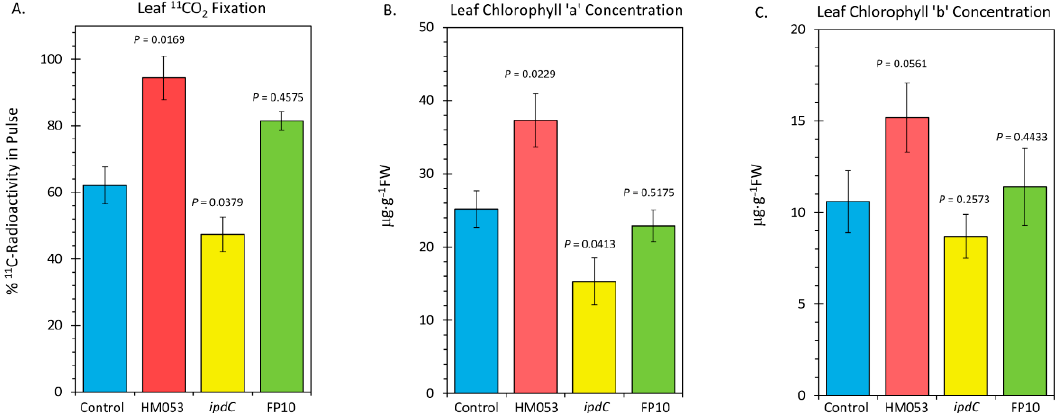
Figure 6. Metrics relative to performance of leaf photosynthesis change upon root inoculation with mutant strains of A. brasilense relative to non-inoculated control. Panel ( A ): Fixation of 11 CO 2 presented as percent of 11 C-radioactivity in the pulse. Data were normalized to uniform leaf masses affixed within the leaf cuvette. Panel ( B ): Leaf concentration of chlorophyll a presented in micrograms per gram dry weight of tissue ( µ g · g − 1 DW). Panel ( C ): Leaf concentration of chlorophyll b ( µ g · g − 1 DW). Data bars reflect means ± SE. The number of biological replicates was defined by the number of plants we examined per treatment (Control, N = 6 plants; HM053-inoculated, N = 6 plants; ipdC -inoculated, N = 4 plants; FP10, N = 6 plants). Statistical significance was based on p < 0.05. Numeric ratios of chlorophyll a to chlorophyll b are also posted in Panel C as R a/b values.